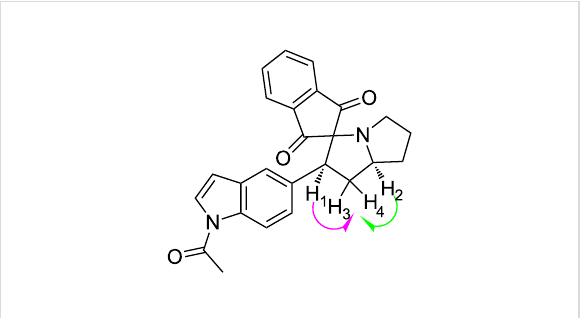
Figure 1: NOE interactions in compound 8c supporting the stereo- chemical assignments for 8a–k . H 1 and H 2 on the asymmetric carbon atoms were found to be syn